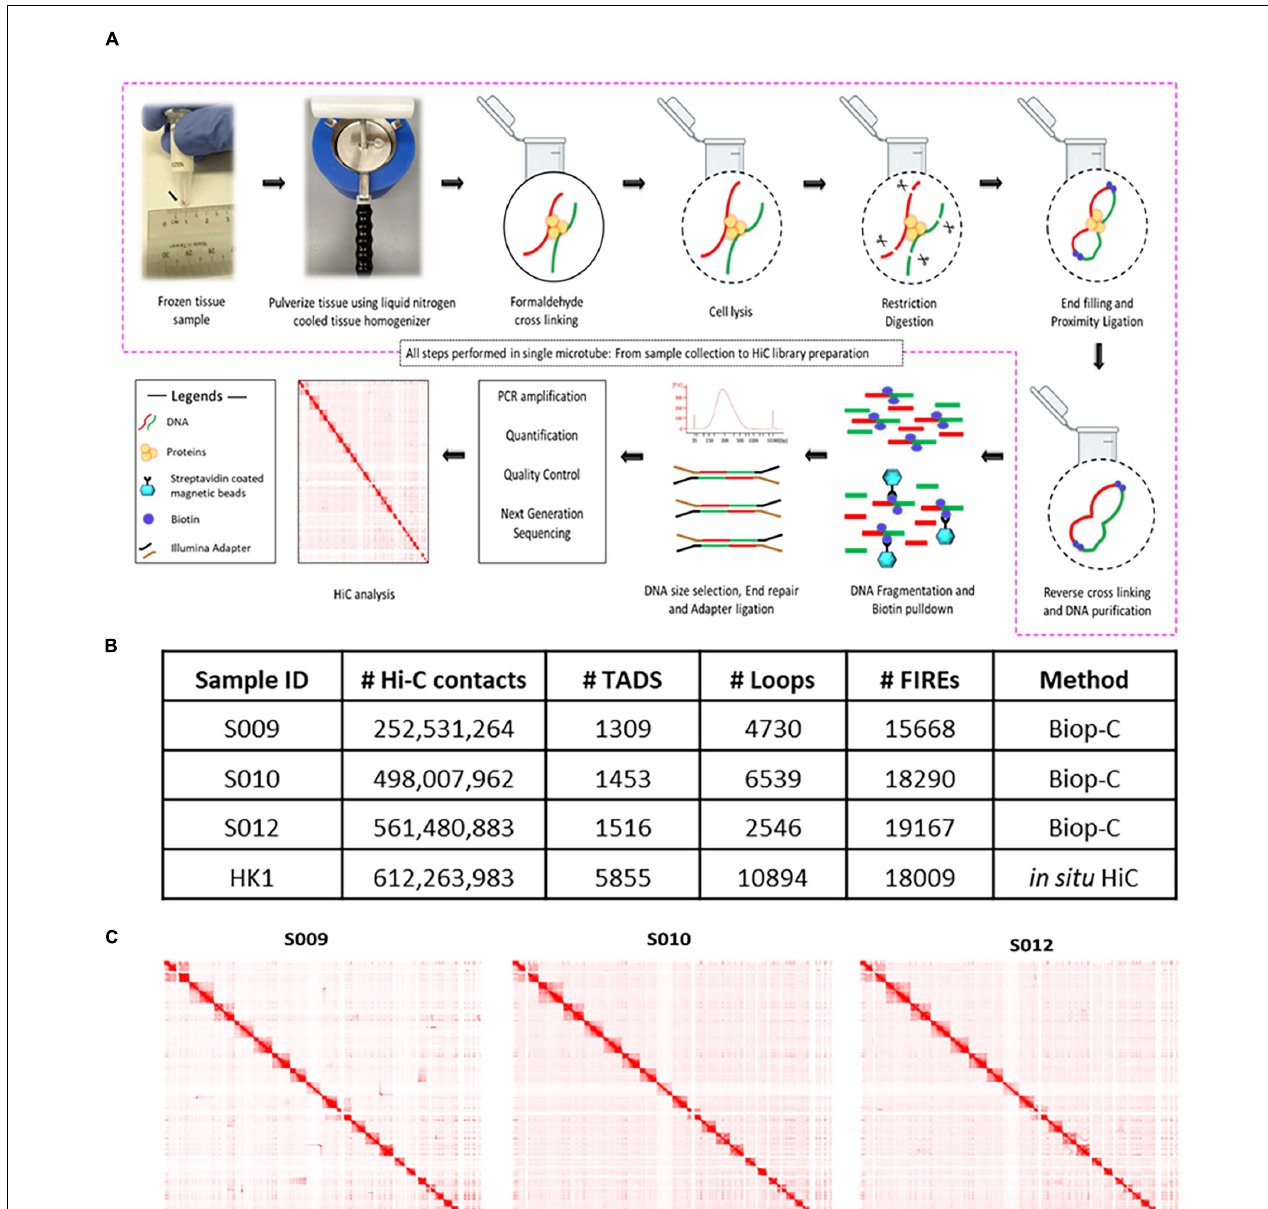
FIGURE 1 | Biop-C method enables the study of high-resolution 3D genome organization and chromatin interactome in solid tumor samples. (A) Schematic overview of the Biop-C method. The frozen needle biopsy tissue is pulverized in a liquid nitrogen-cooled mini mortar, and then chromatin was fixed with formaldehyde in the nucleus. The samples were processed with commercial Arima genomics Hi-C kit. Fixed cells were permeabilized using a lysis buffer supplied in Arima Hi-C kit and then digested with a restriction enzyme. Following restriction digestion, the sites were filled in with biotinylated nucleotides. The resulting DNA blunt ends were subsequently ligated. After ligation, crosslinks were reversed to remove proteins from DNA. Hi-C material was then sonicated using a Covaris Focused-Ultrasonicator M220 instrument to achieve fragment sizes of 300–500 bp. The sonicated DNA was double-size selected using AMPure XP beads, and the sequencing libraries are generated using low input Swift Bioscience Illumina-compatible adapters. (B) Table of statistics of Biop-C and Hi-C data. #Hi-C contacts indicate the number of mapped/valid junction reads of each library. #TAD indicates the number of TADs called from Biop-C and Hi-C data at 10 kb resolution. #Loops indicates the total number of loops called from Biop-C and Hi-C data at 5, 10, and 25 kb resolution and then merged. #FIREs indicates the number of FIREs called from Biop-C and Hi-C data at 10 kb resolution. (C) Juicebox (Durand et al., 2016) visualized Biop-C and Hi-C heatmaps showing all chromosomes for S009, S010, S012, and HK1 cell